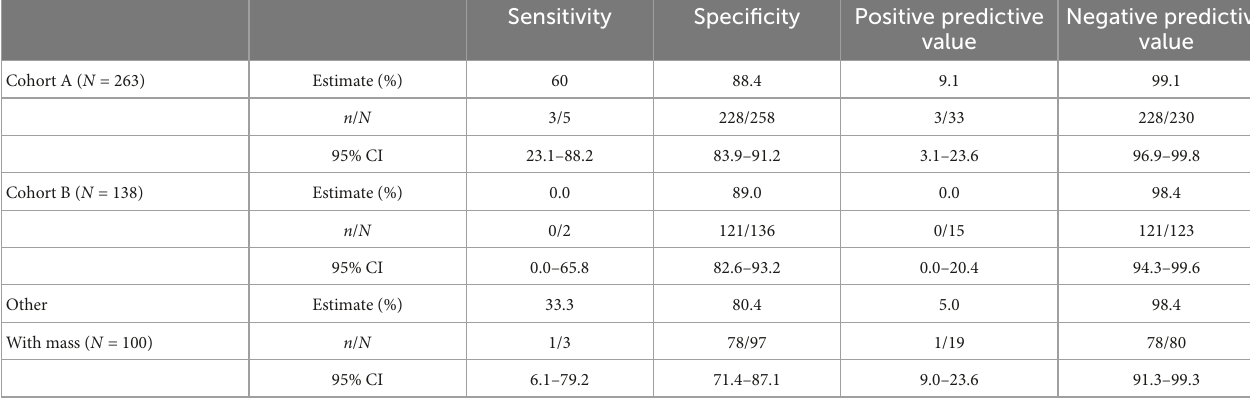
TABLE 3 Performance of OVAWatch stratified by symptom